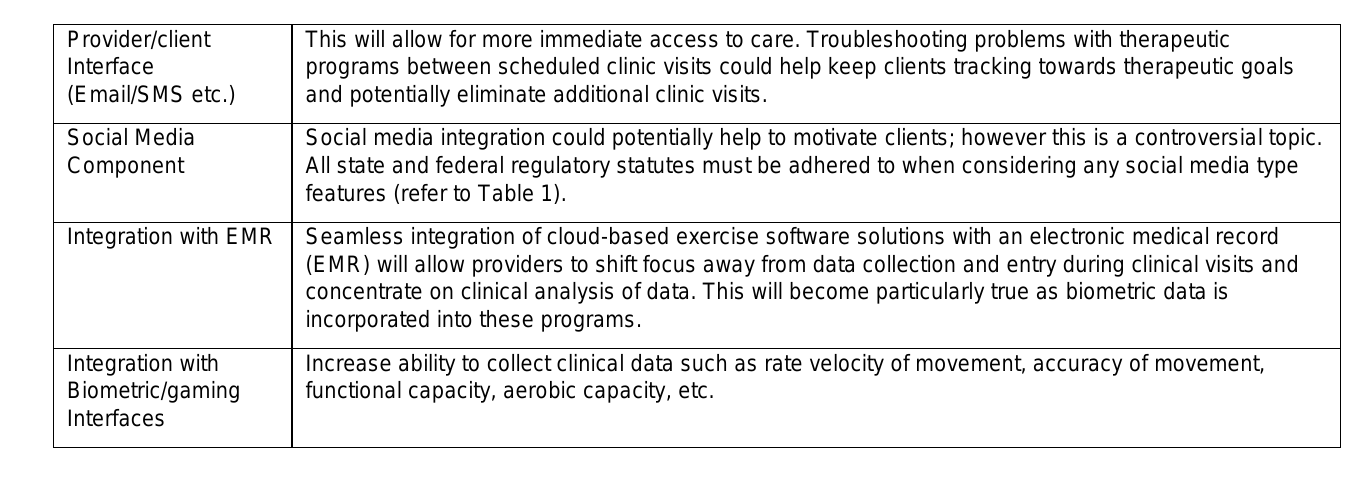
Table 3 outlines the features of three cloud-based store and forward software solutions as compared to a commonly used non-cloud based solution that is widely used in